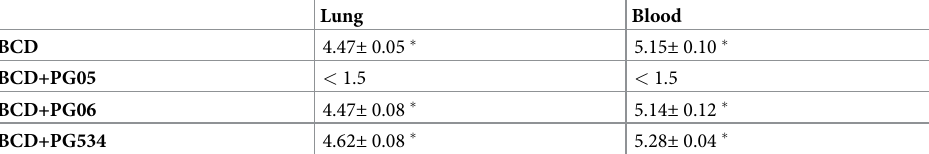
Table 1. Resistance to pneumococcal infection.